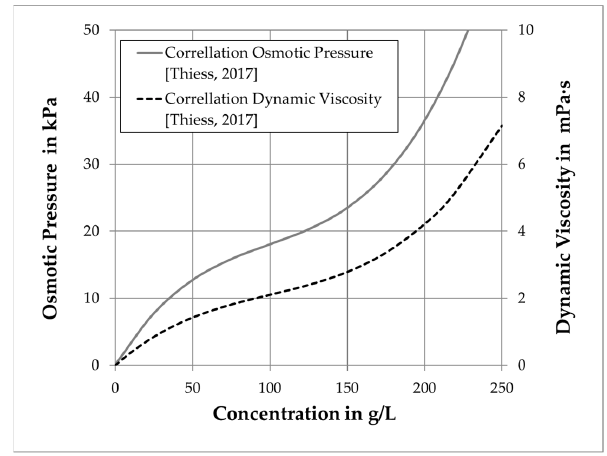
Figure 4. Dependency of osmotic pressure and dynamic viscosity of bovine serum albumin (BSA) concentration.